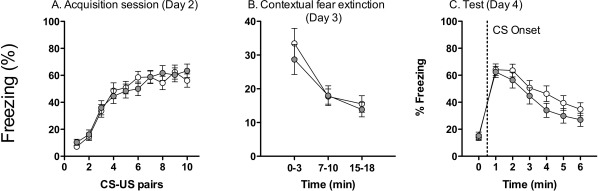
Acquisition, contextual fear extinction and cued test of conditioned fear.Data show the freezing scores (%) over the 10×30 s CS presentations in the acquisition session (Day 2; A), the 3×3 min sampling intervals in the context extinction session (Day 3; B) and for the 3 min interval prior to CS onset, followed by the 6×1 min time bins after CS onset in the retention test session (Day 4; C) for control (n = 31) and DVD-deficient (n = 31) mice in the NPE group. Data are expressed as mean ± SEM.